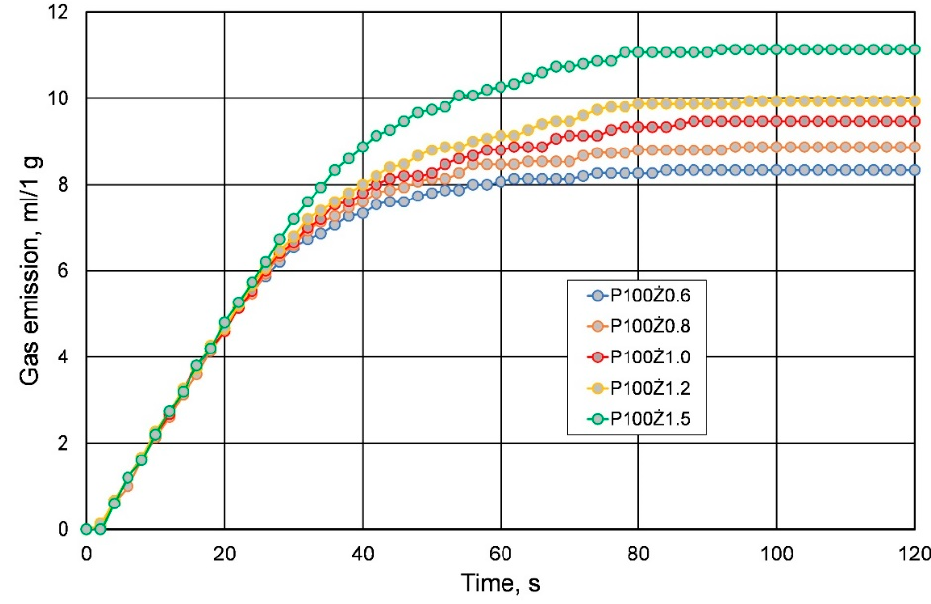
Figure 8. Measurement of gas emission of molding sands with different resin content.